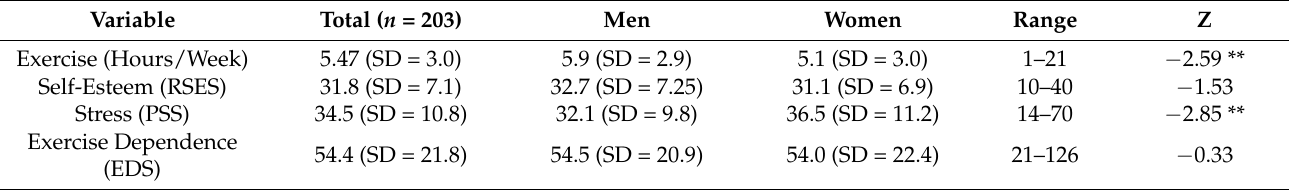
Table 1. Descriptives and outcome measures by gender.